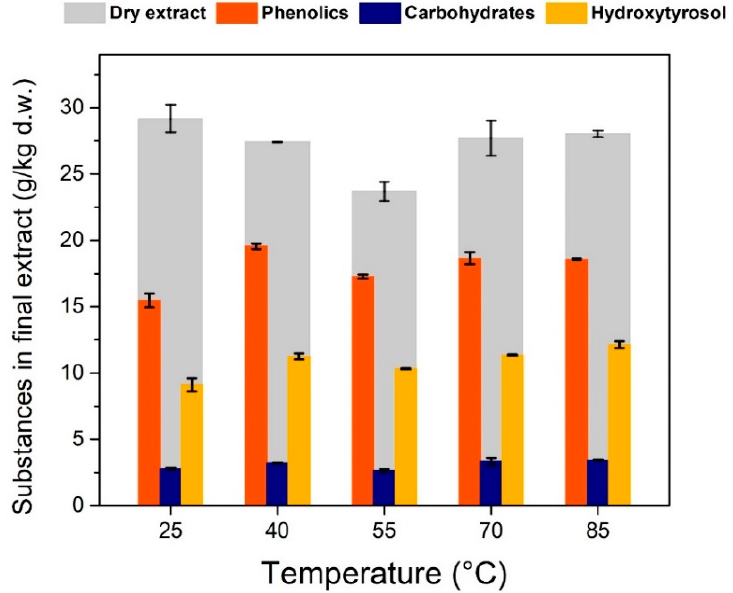
Figure 9. Effect of temperature during solid–liquid extraction, with 70% ( v / v ) ethanol, on the substance profile in the final extract. Hydrolysis was performed with H 2 SO 4 at pH 1 and boiling under reflux for 15 min.